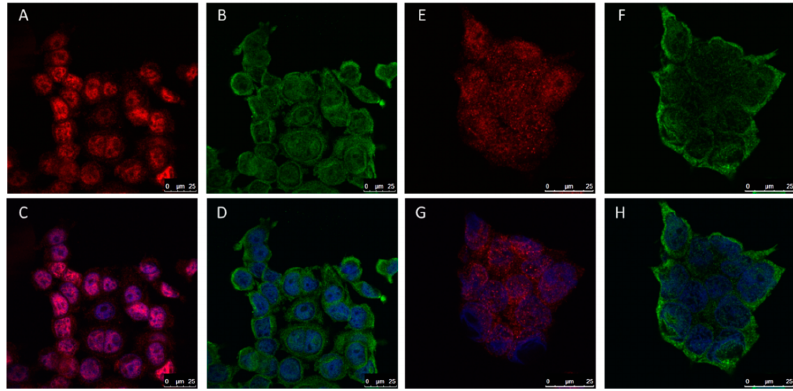
Figure 8. Immunofluorescent staining of two breast cancer cell lines: MCF7 ( A – D ) and BT474 ( E – H ). Staining for: ER α 66 (red), ER α 36 (green), and nucleus (blue).